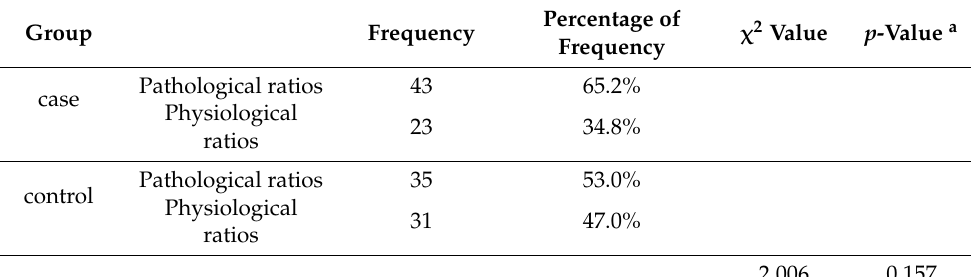
Table 4. Electromyographic analysis (chi-squared test). Frequencies of pathological and physiological ratios in case and control groups. Group